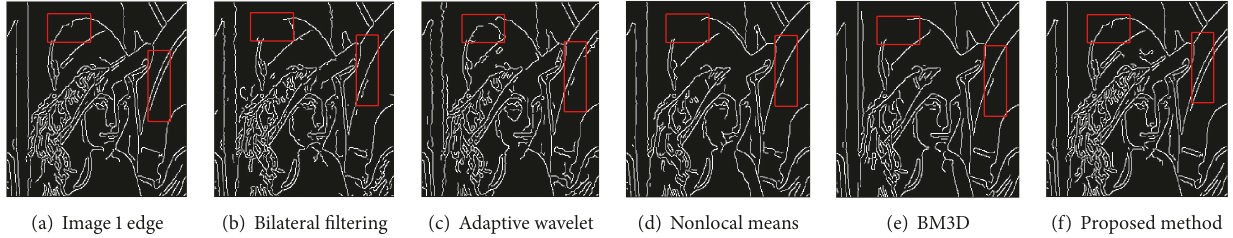
Figure 13: Image 1: edge comparison of various experimental results under noise variance 𝜎 2 = 0.03 .